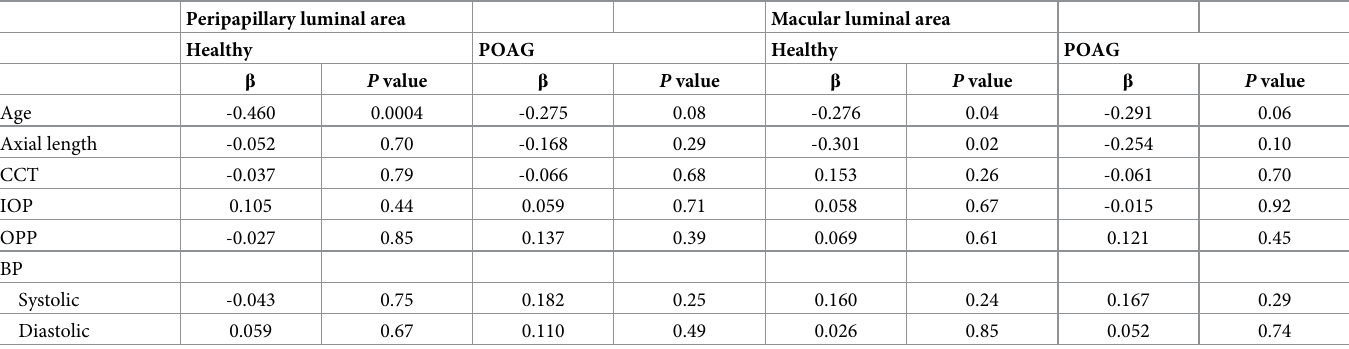
Table 5. Univariate regression analysis of choroidal luminal area with associated factors.